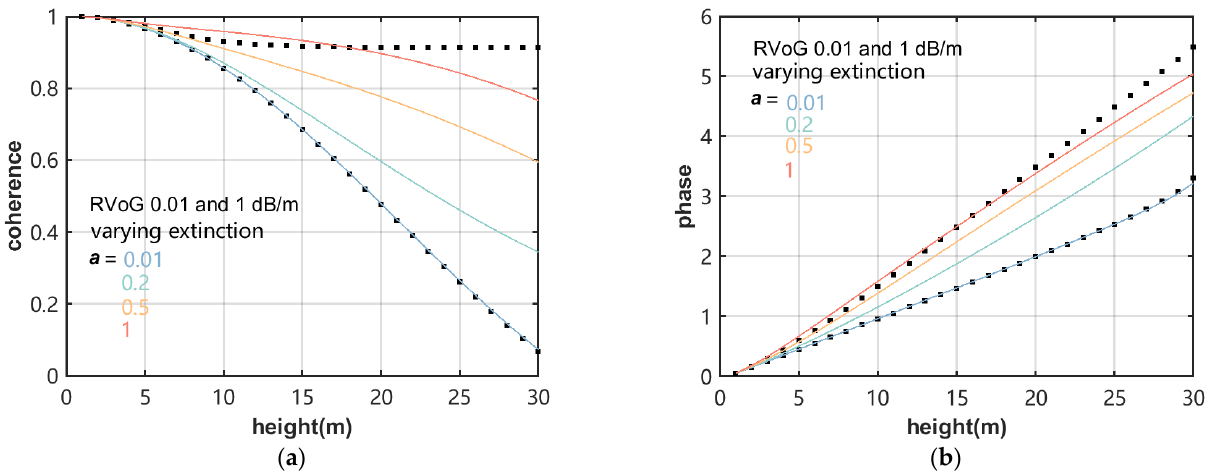
Figure 9. Volume coherence and interference phase plots obtained for different extinction coefficients. ( a ) Volume coherence and height diagram with different extinction coefficients. ( b ) Interference phase and height diagram with different extinction coefficients. The fixed extinction coefficients (0.01 and 1 dB/m) are represented by black dots, and the extinction coefficient influence factors (0.01, 0.2, 0.5 and 1 dB/m) are represented in blue, green, yellow and red, respectively.